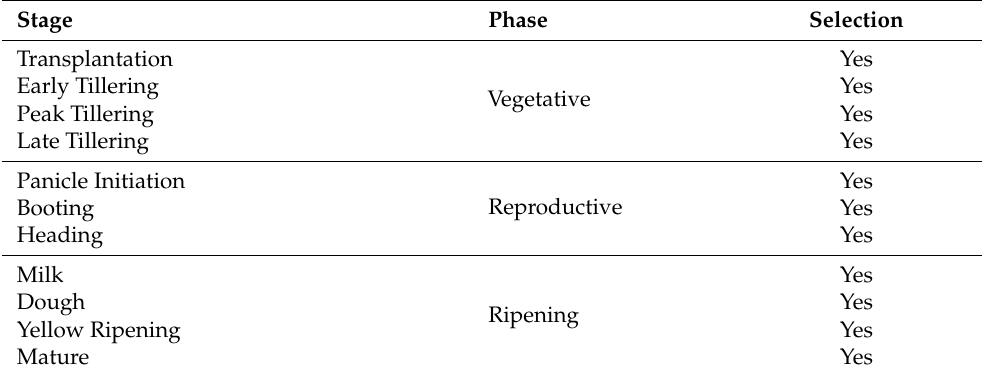
Figure 3. The Second Rice Farming Period and Related SOP. Table 1. Growth Stages of Paddy Rice Sorted by TGAP and Our Experts for Classification